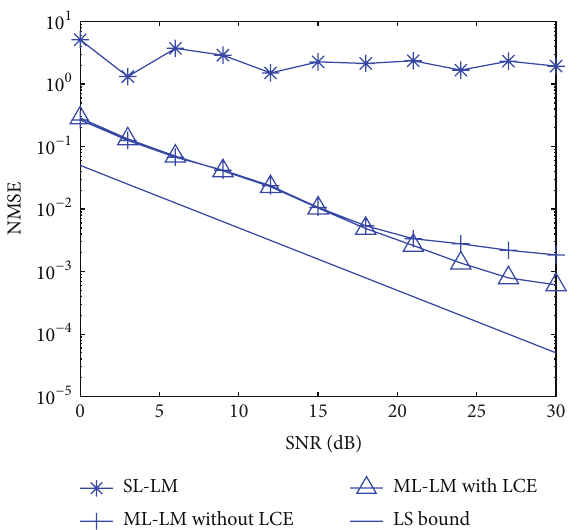
Figure7:NMSEcomparisonsofSL-LMandML-LMiterationwhen 𝐿 = 80 (with and without LCE).